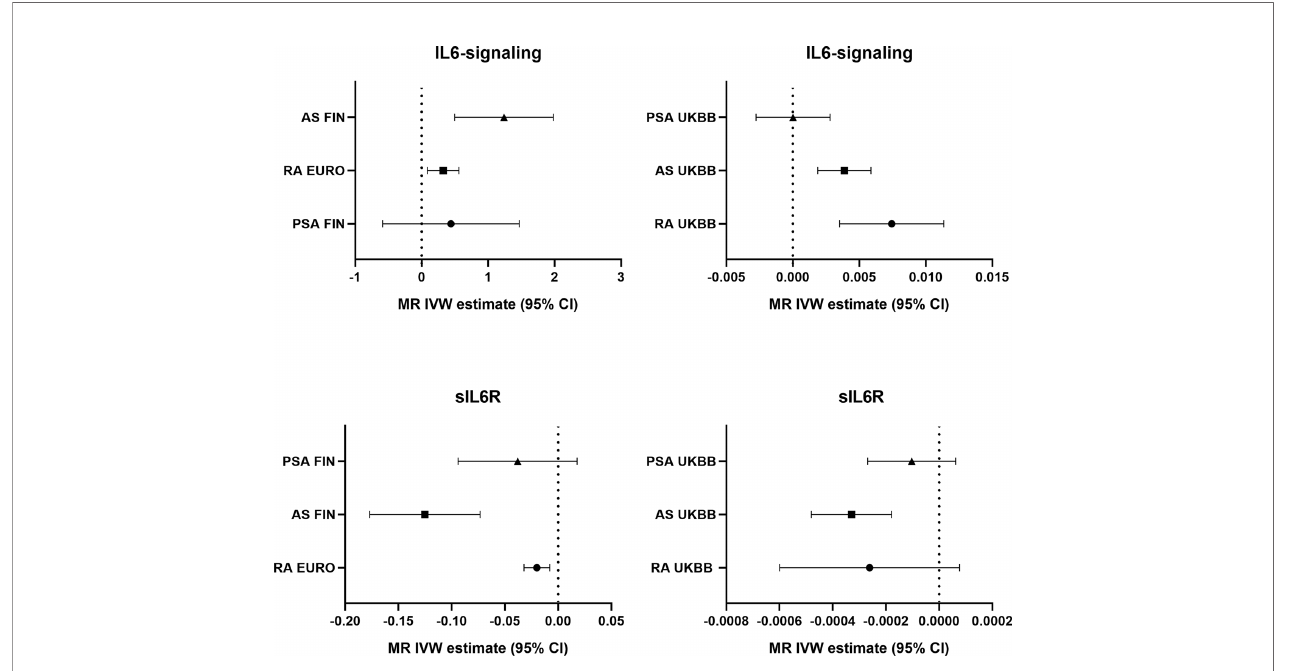
FIGURE 2 | Forest plot of the causal effects of IL6-signaling and sIL6R on autoimmune arthritis.